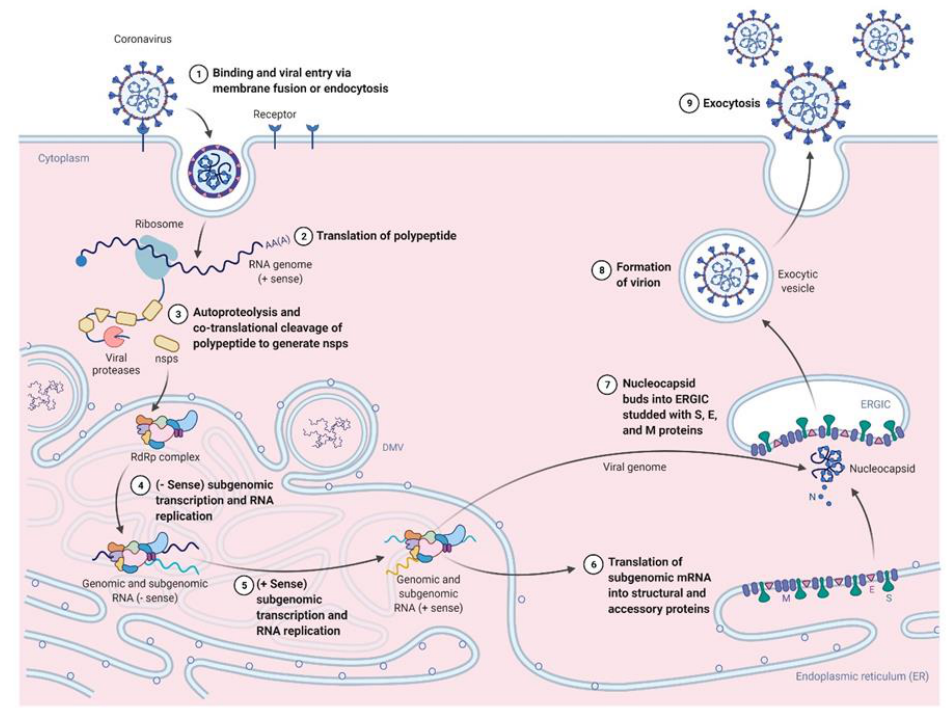
Figure 1. The SARS-CoV-2 life cycle.